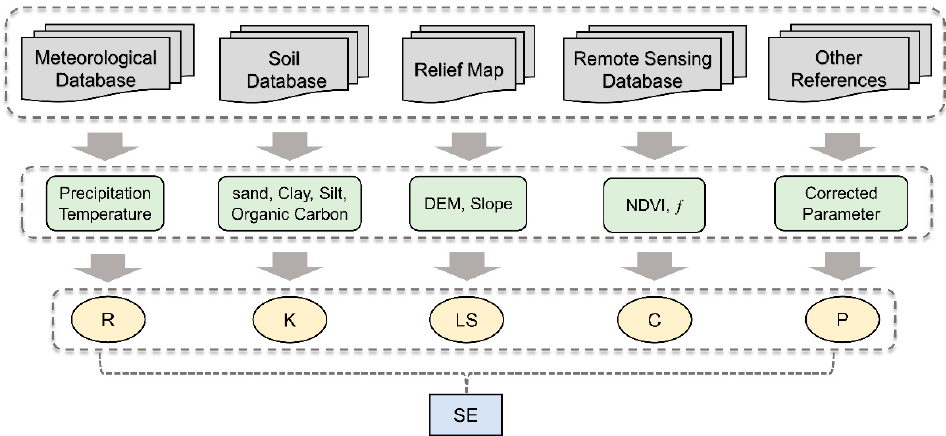
Figure 2. Workflow of the application of the SE model to CA .